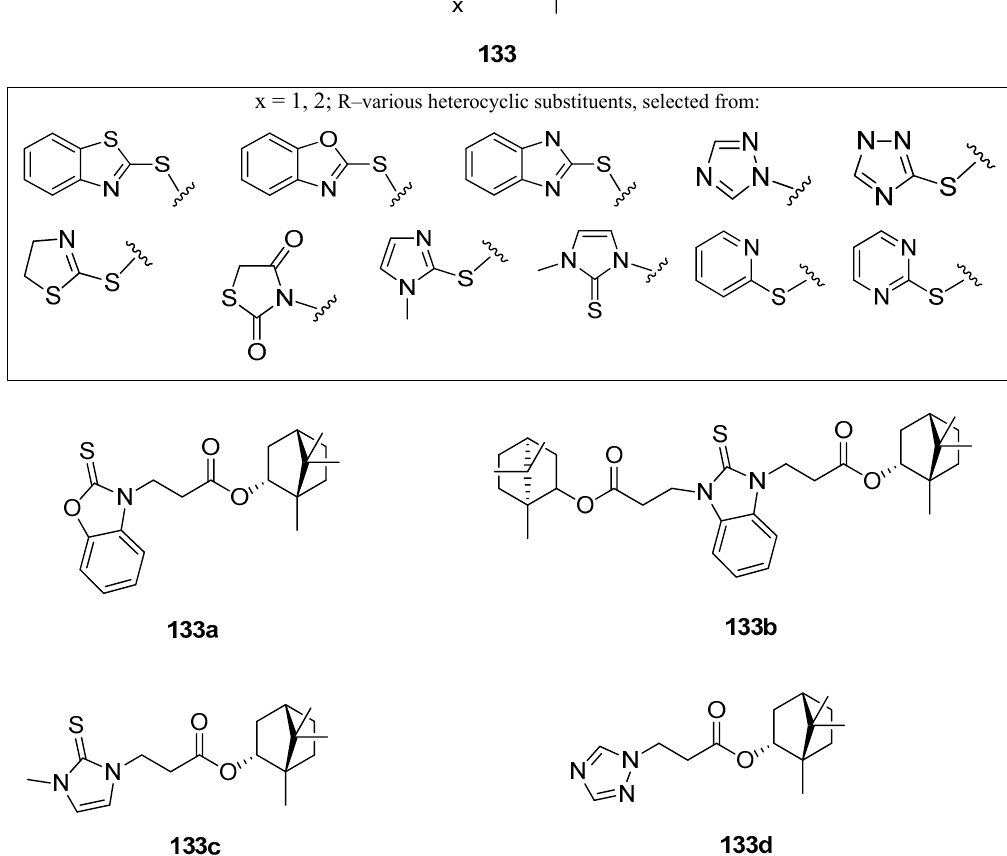
Figure 38. (–)-Borneol ester derivatives with different N - and S -nucleophiles.